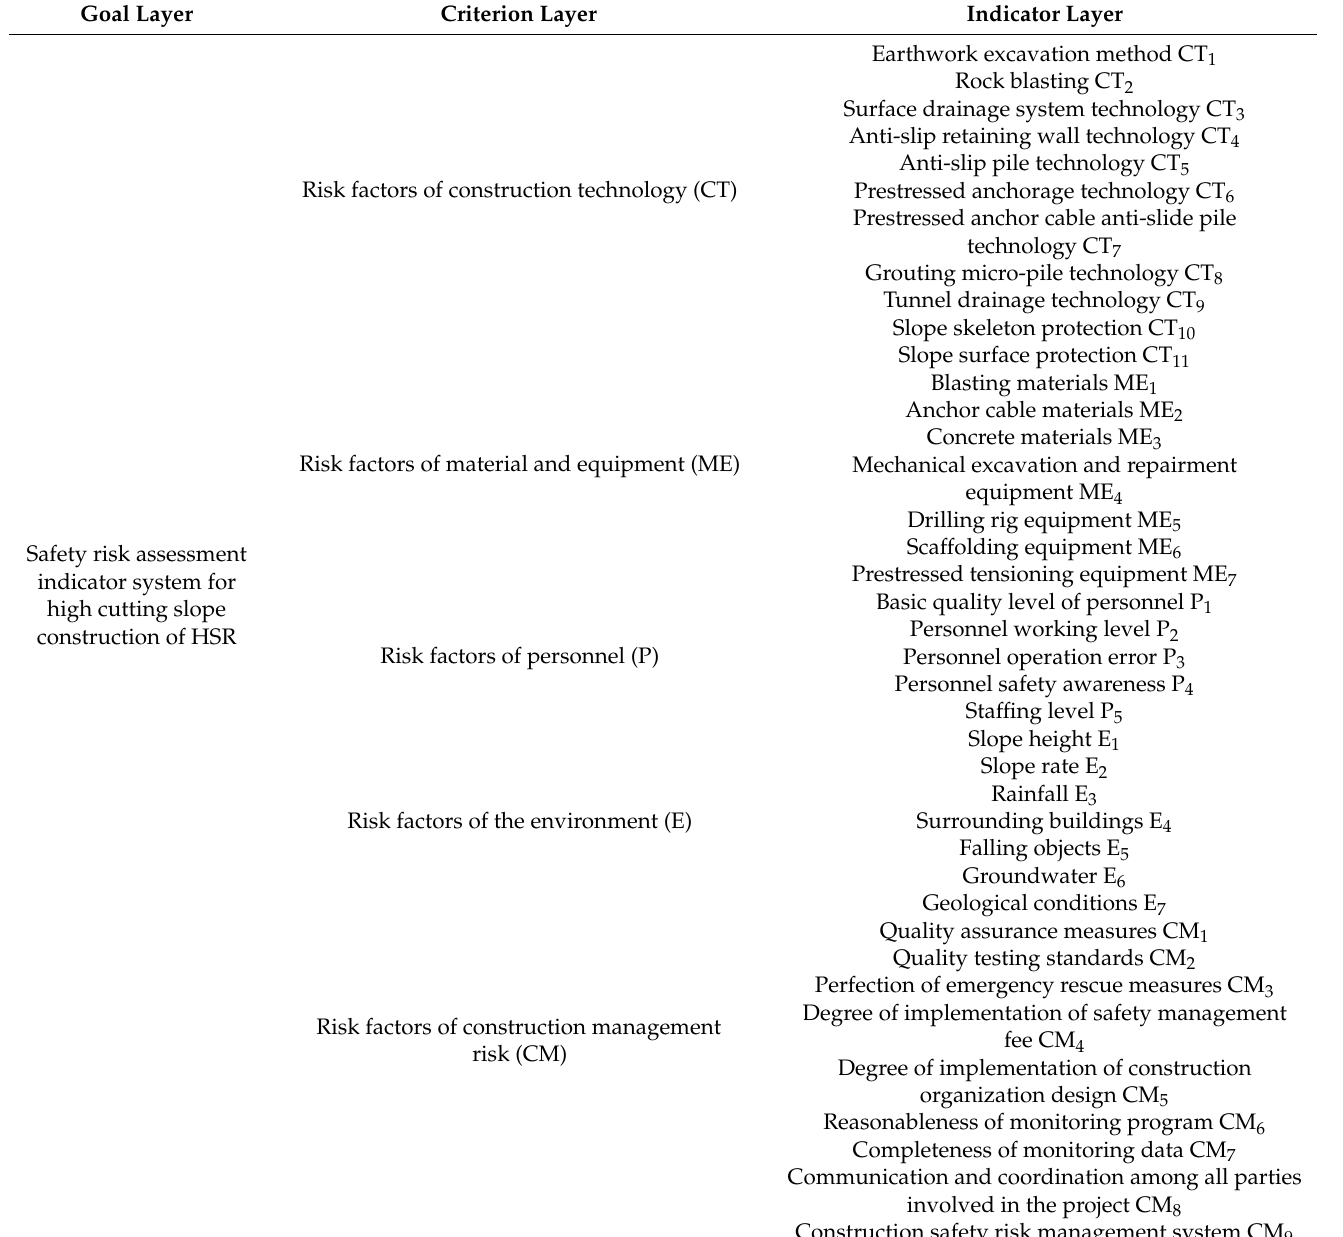
Table 4. Safety risk assessment index system for high cutting slope construction of